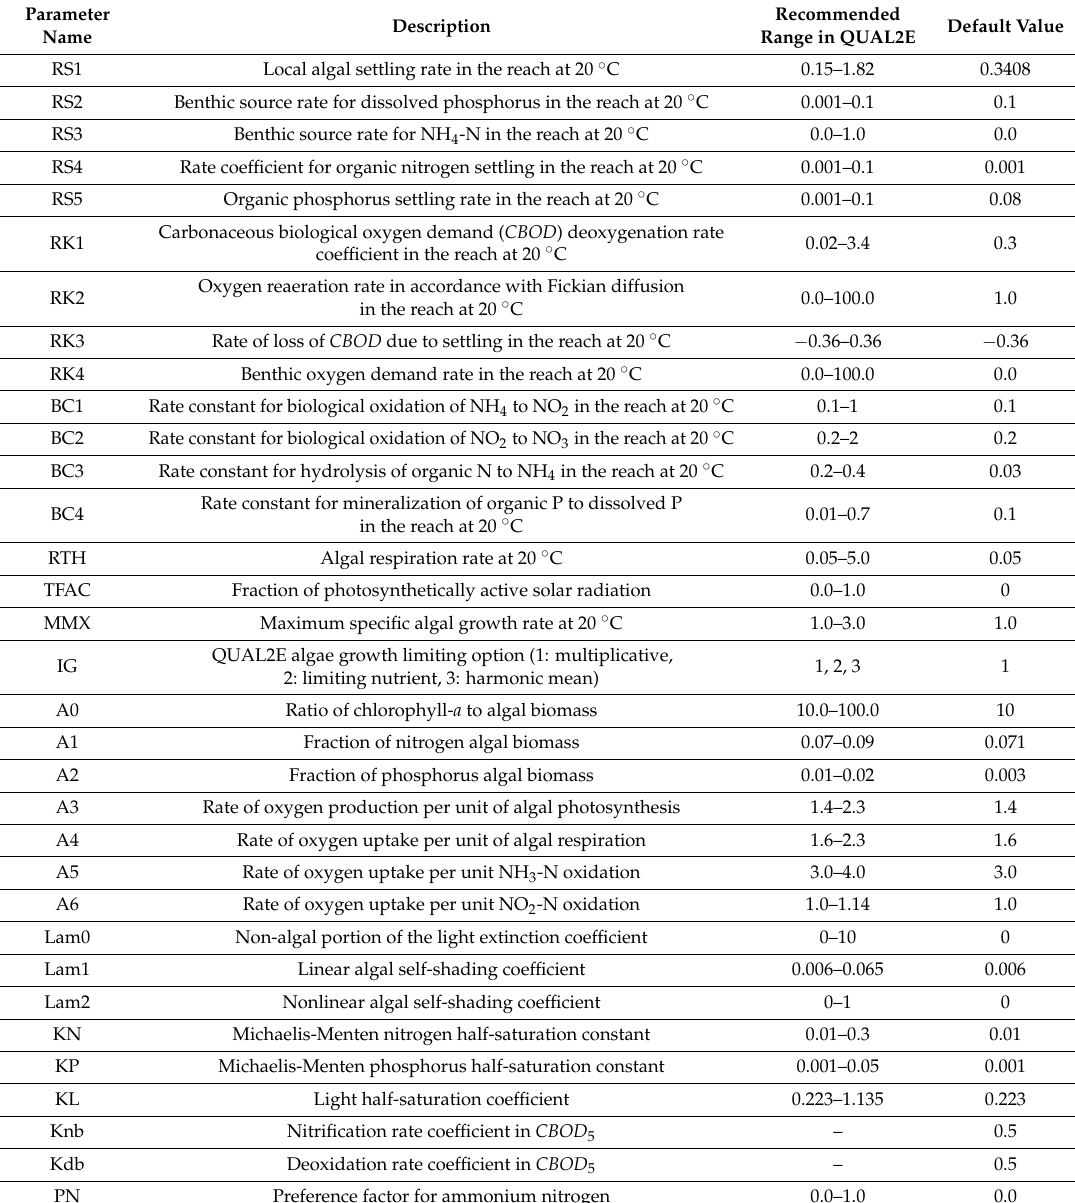
Table 3. Description of QUAL2E parameters used in instream water quality